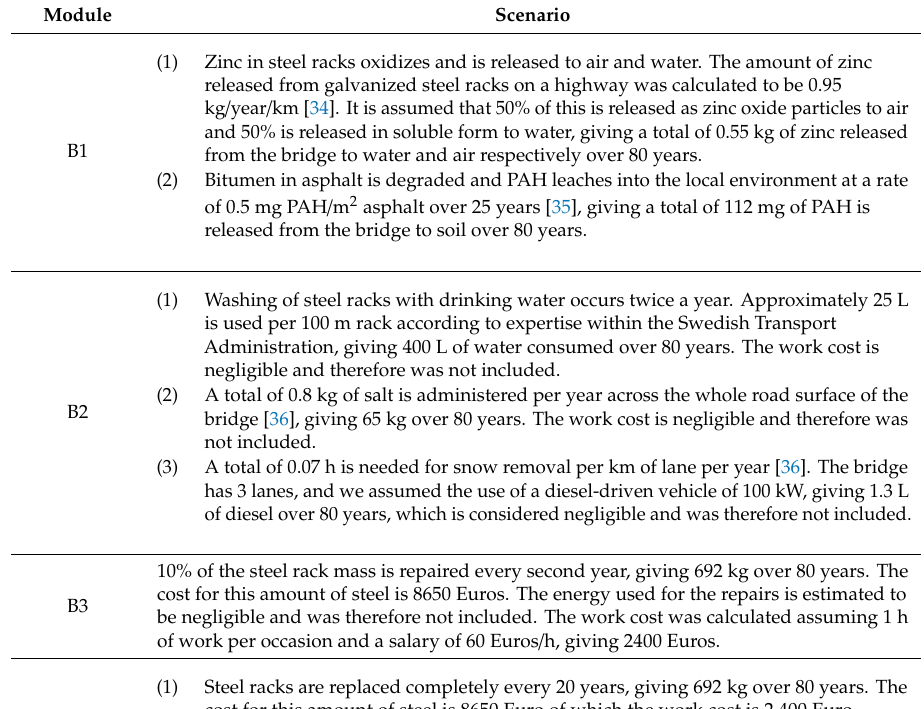
Table A3. Common scenarios for both design concepts for each module